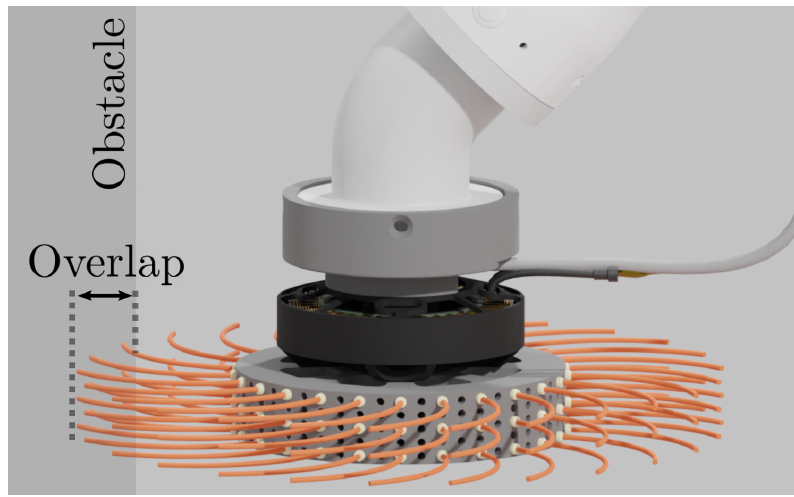
Figure 5. The torque applied by the tool depends on its overlap with the obstacle. An experiment is conducted in order to estimate the relationship between the mentioned values.